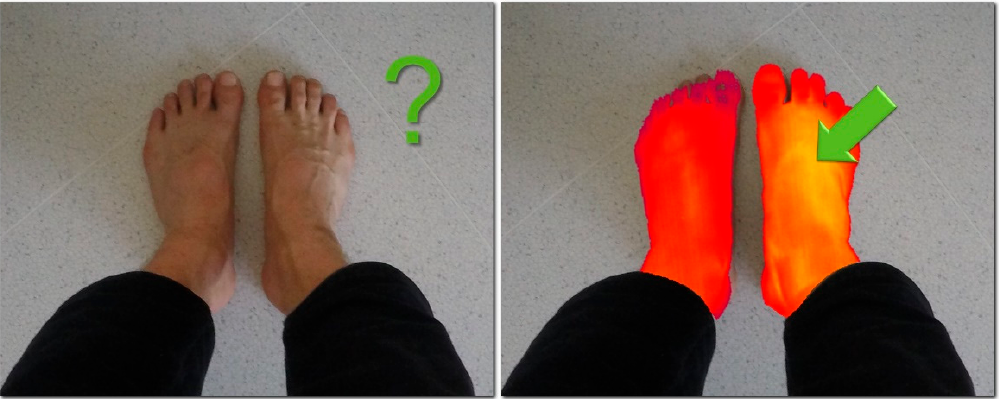
Figure 1. The symptoms have not progressed far enough to be observable ( left ), but the inflammation is already clearly visible in the thermal image ( right ).